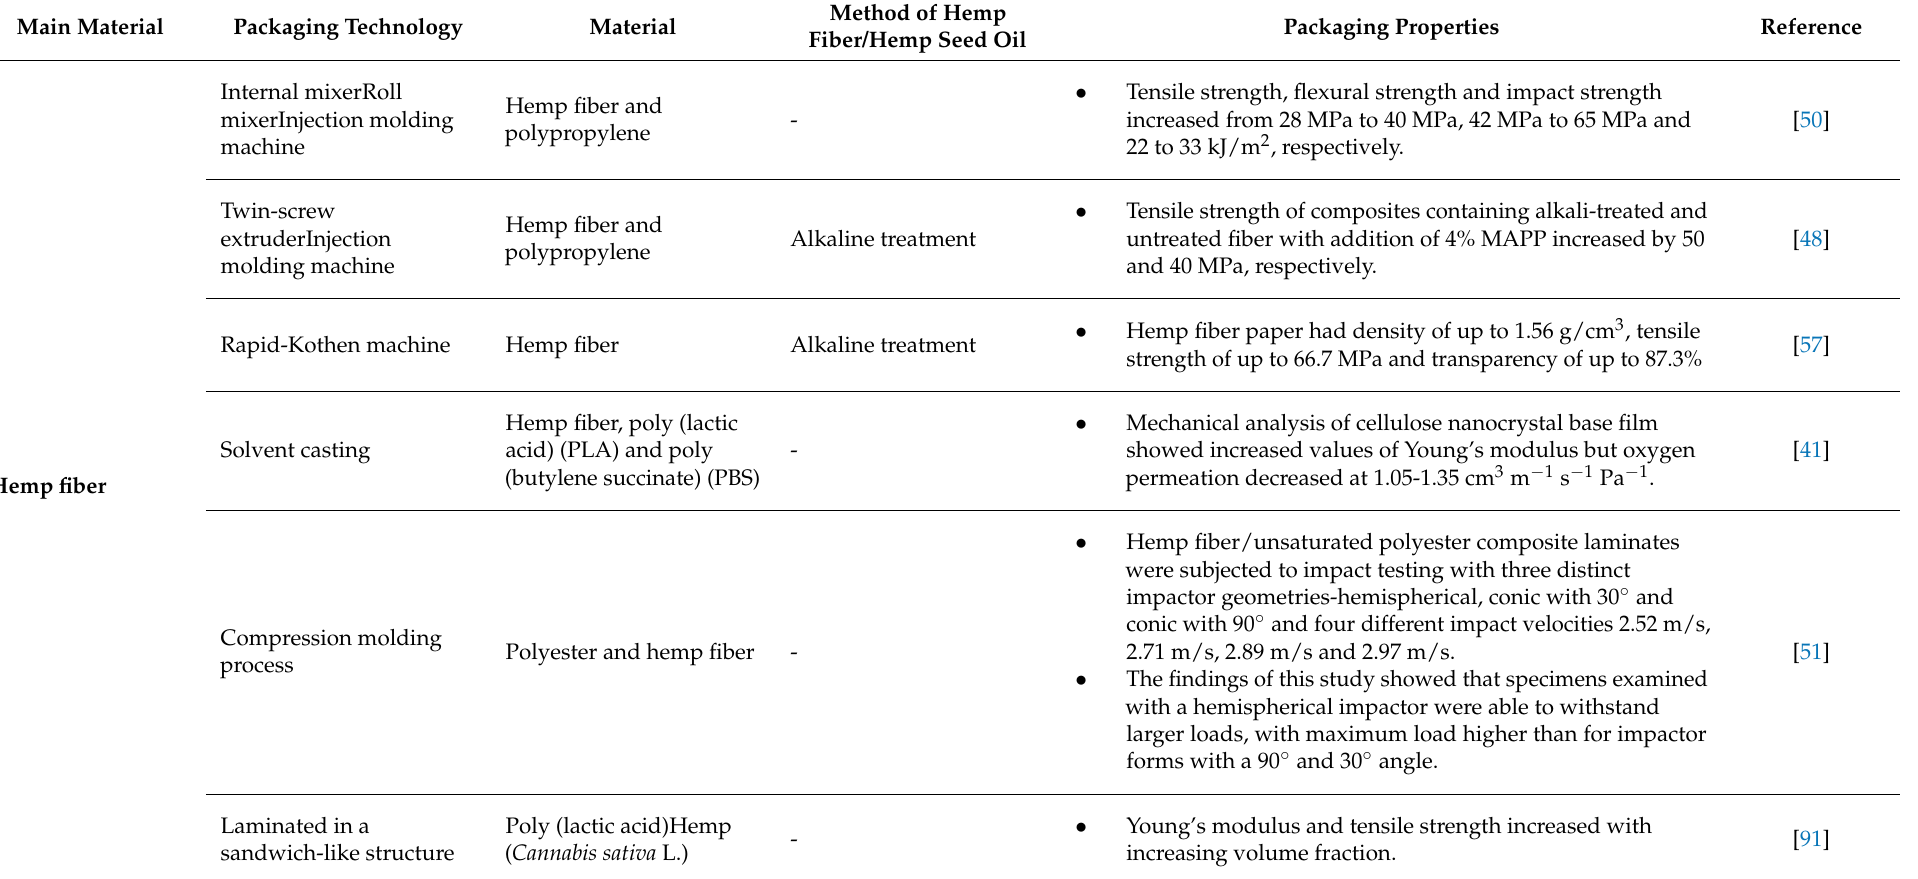
Table 4. Related researches on utilization of hemp components in packaging and